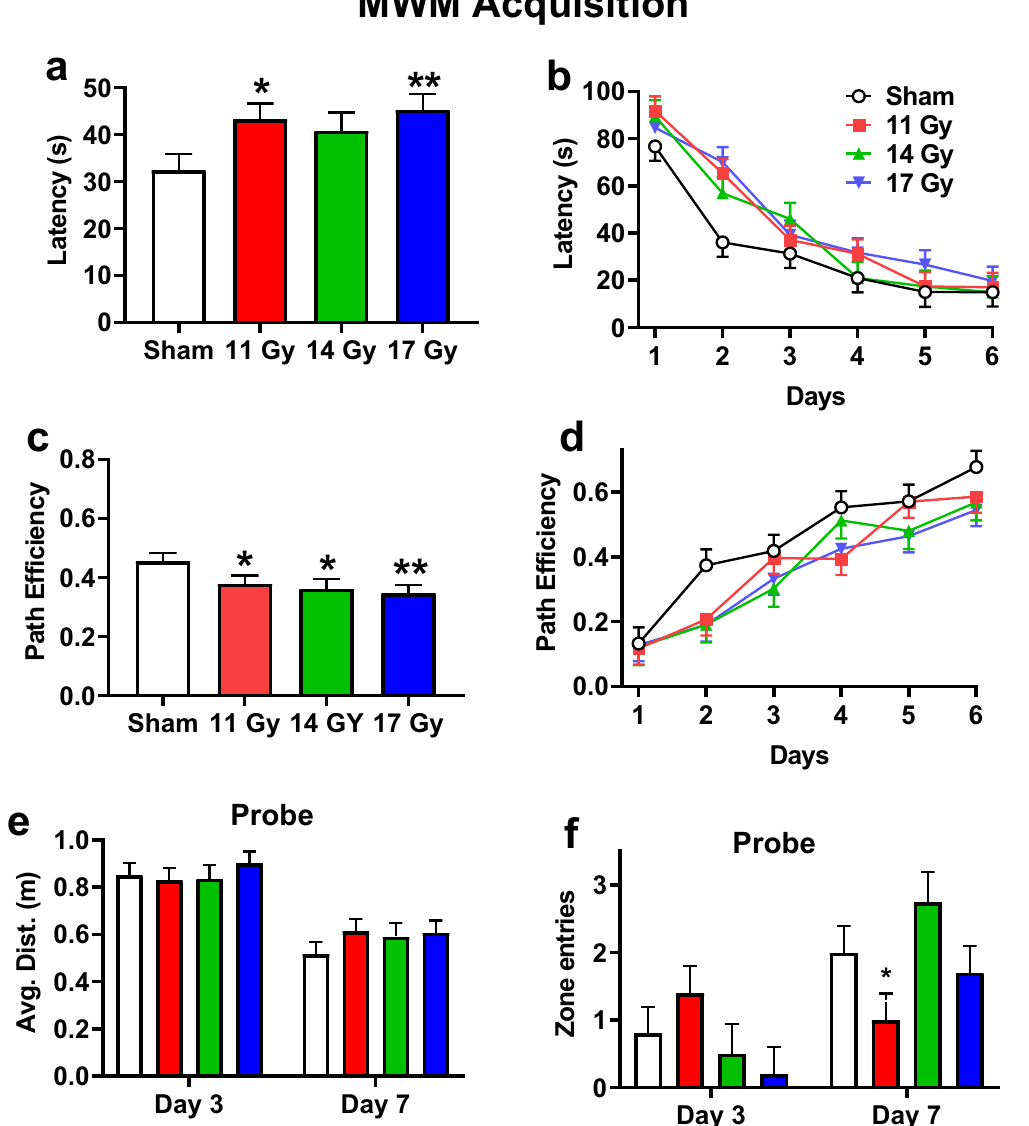
Figure 7. Acquisition phase Morris water maze performance in proton irradiated and control rats. ( a ) Overall effect on latency to the platform. ( b ) Learning curve for latency with all groups. ( c ) Overall effect on path efficiency. ( d ) Learning curve for path efficiency. e. Average distance from the former platform site on day-3 and day-7 probe trials. ( f ) Number of entries into the former platform site on day-3 and -7 probe trials. There was an interaction for entries with the 11 Gy rats having fewer entries than the controls. * p < 0.05, ** p < 0.01 compared with controls. N = 10/control, 11 Gy, and 17 Gy and n = 8 for the 14